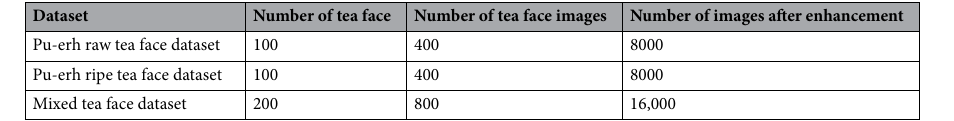
Table 1. Training dataset data.